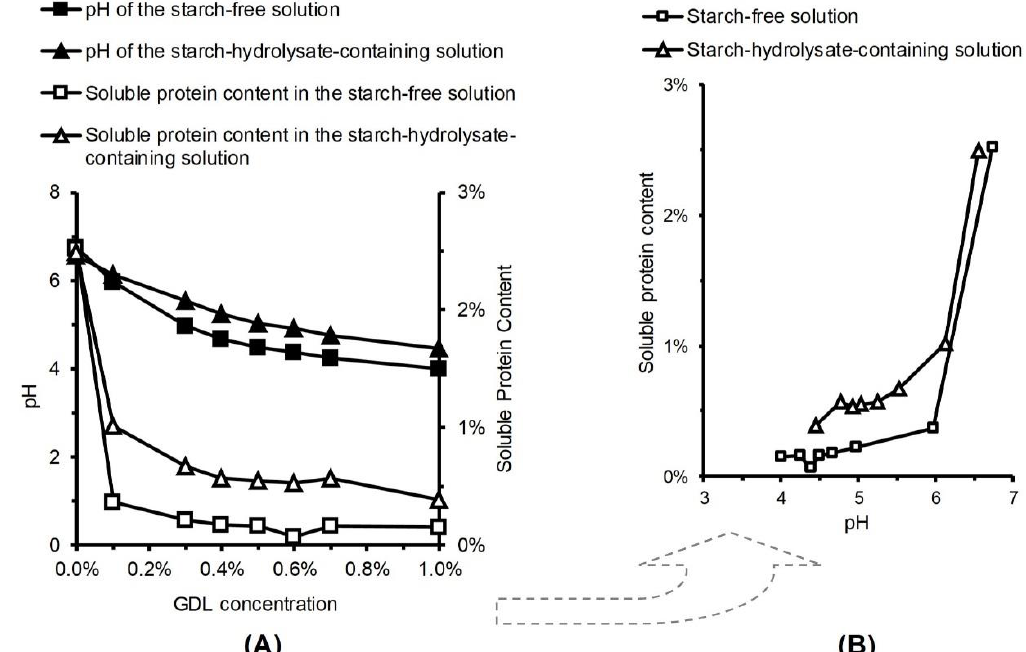
Figure 8. The pH and soluble protein content of the faba bean starch-free and starch-hydrolysate-containing solutions having different concentration of glucono-delta-lactone (GDL) ( A ). The same data was replotted to show the relationship between the soluble protein content and pH ( B ). Each point shows the average of duplicate measurements.